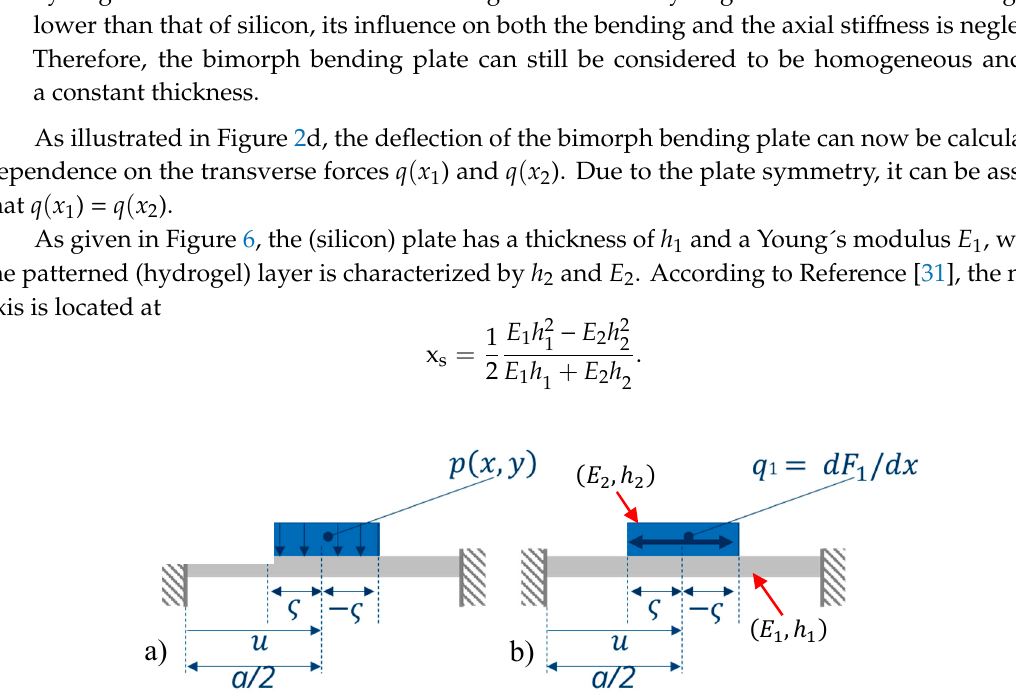
Figure 6. Analogy between ( a ) the rectangular plate from Figure 5 and ( b ) a bimorph plate, where the bimorph is located in the plate center.